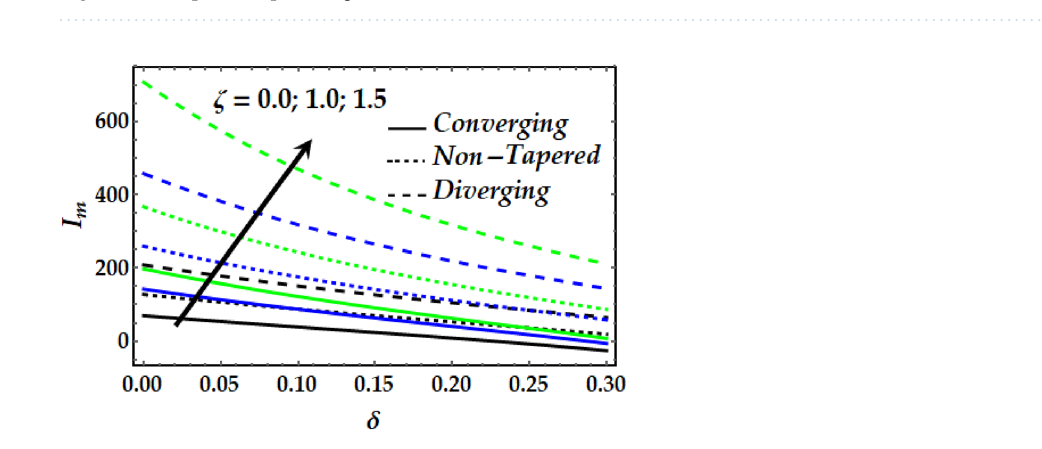
Figure 17. Impedance profile against distinct values of ζ